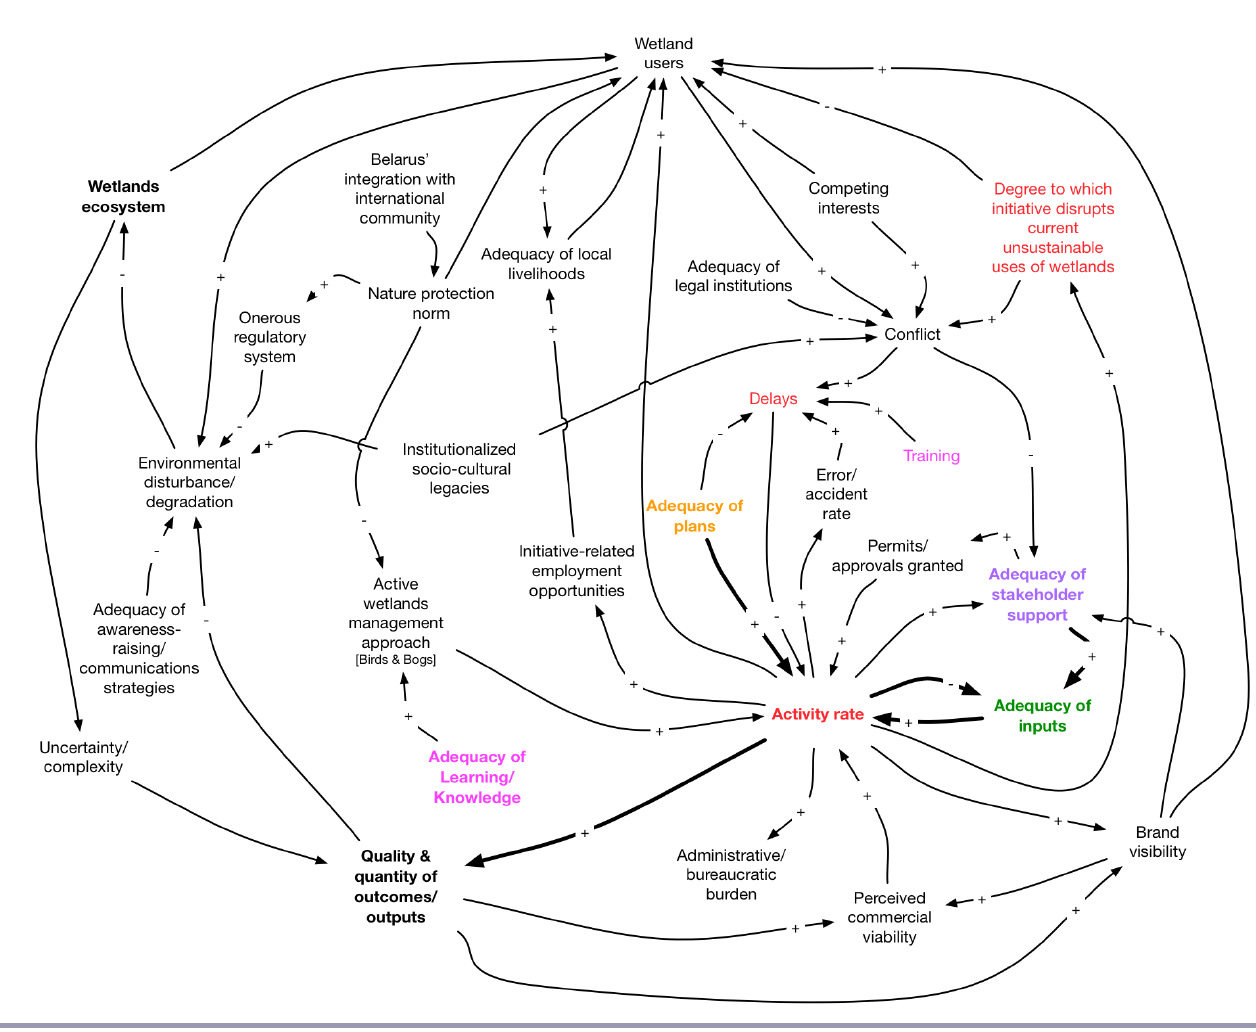
Fig. 9 . Submodel unpacking causal dynamics influencing the activity rate of wetland restoration initiatives in Belarus. Entrenched socio-cultural legacies of indifference and carelessness regarding the negative impacts of some users on wetlands were identified as a driver of environmental disturbance and degradation. All three cases sought, therefore, to shape public attitudes through a variety of direct awareness-raising and knowledge dissemination activities, and/or through indirect use of power, e.g., refusing to purchase unripe berries in order to affect change in picking behaviors. Brand visibility also influenced the number and types of